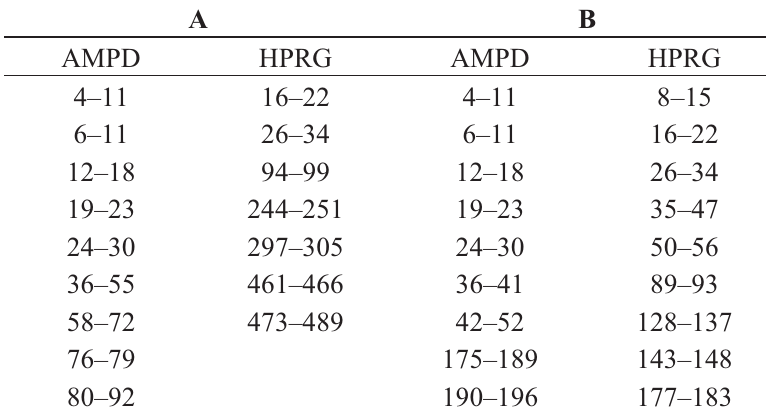
trypsin/AMPD 1:80, w / w ). ( A ) N -terminal sequences of the fragments of AMPD